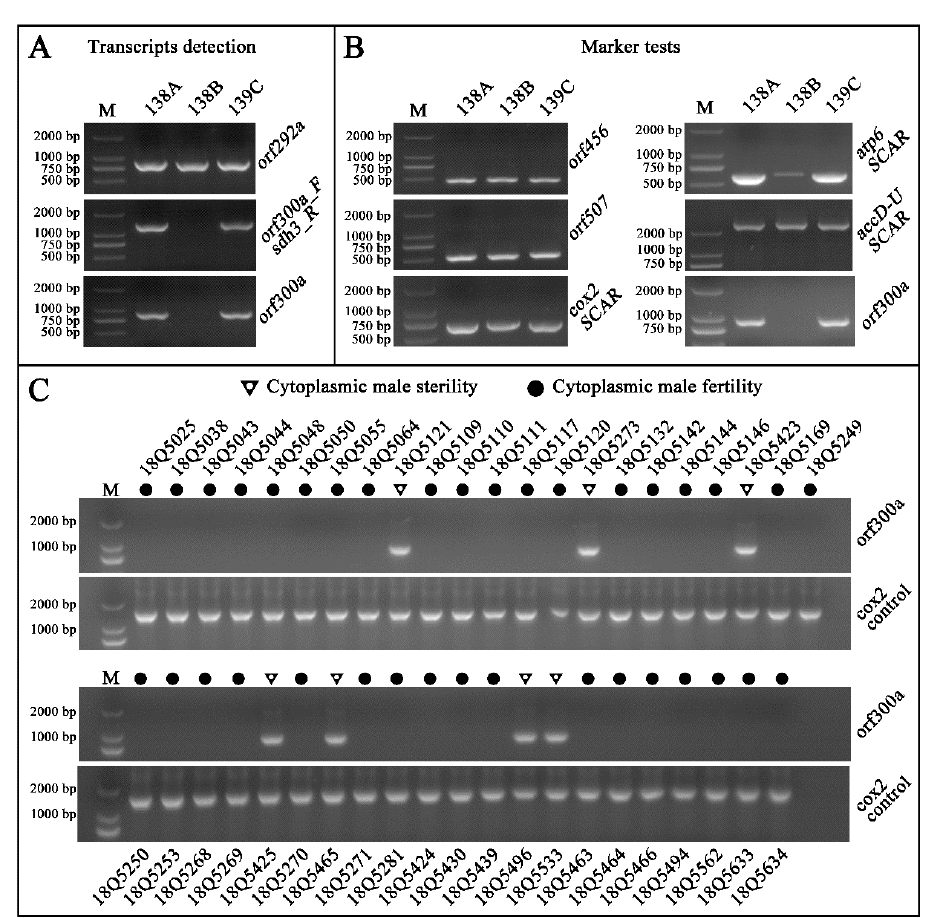
Figure 5. Results of PCR amplification. ( A ) Transcript detection of orf292a , co-transcript detection of orf300a-sdh3 , transcript detection of orf300a ; ( B ) CMS makers (orf456, orf507, cox2 SCAR, atp6 SCAR, accD-U SCAR, orf300a) test in 138A, 138B, 139C. ( C ) CMS maker orf300a tests in 43 pepper inbred lines, cox2 positive control.